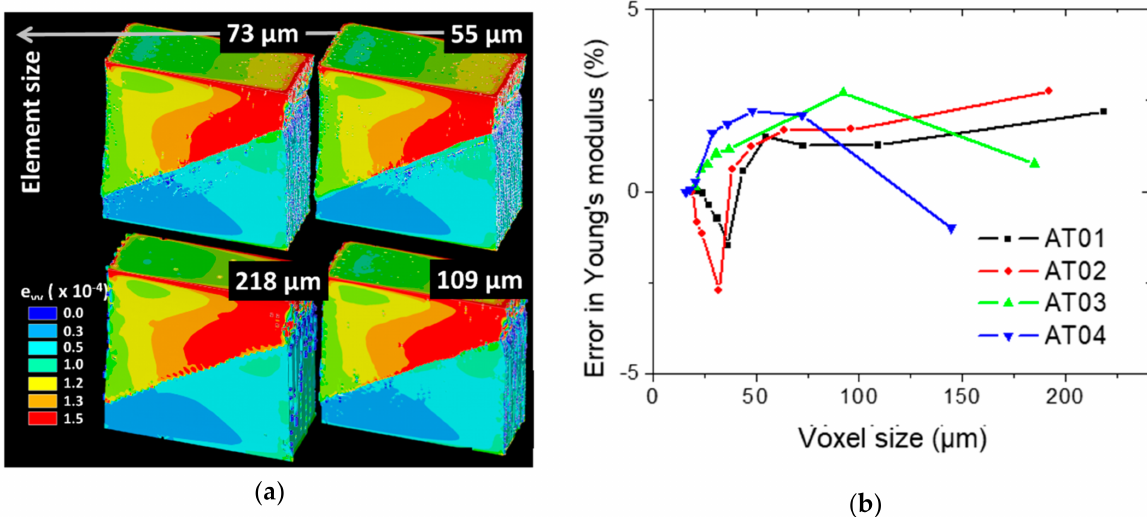
Figure 15. Finite element results: ( a ) longitudinal strain distribution within the AT03 specimen as a function of the element size; ( b ) effect of resolution (element size = voxel size) on the prediction of the Young’s modulus for all printing